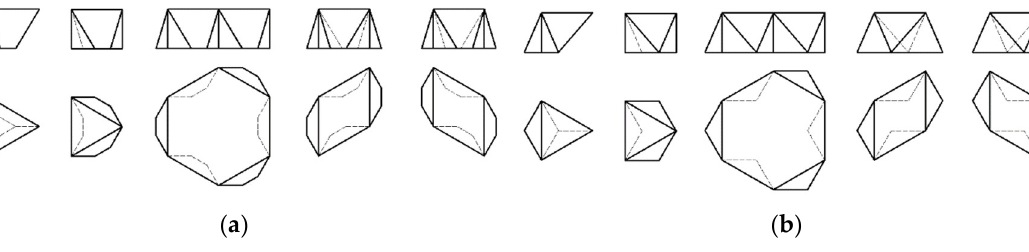
Figure 14. Double-sided smooth vault components based on an equilateral triangle, a regular hexagon, and a rhombus, inspired by Frezier blocks: ( a ) of the first type; and ( b ) of the second type.